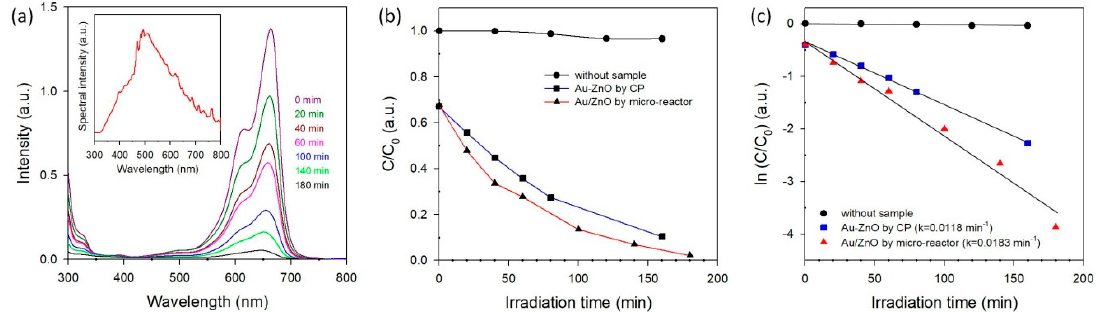
Figure 8. Photocatalytic activities under simulated sunlight of the MB solution without sample, with Au-ZnO by CP, and with Au/ZnO by micro-reactor; ( a ) absorption spectra of the MB solution (10 mg·L − 1 ) with irradiation time in the presence of Au/ZnO (The insert shows the used solar spectrum); ( b ) photocatalytic degradation of MB with irradiation time; and ( c ) a plot of ln (C/C 0 ) versus irradiation time. First-order degradation rate constants were obtained by plotting the natural logarithm of the absorbance versus irradiation time.